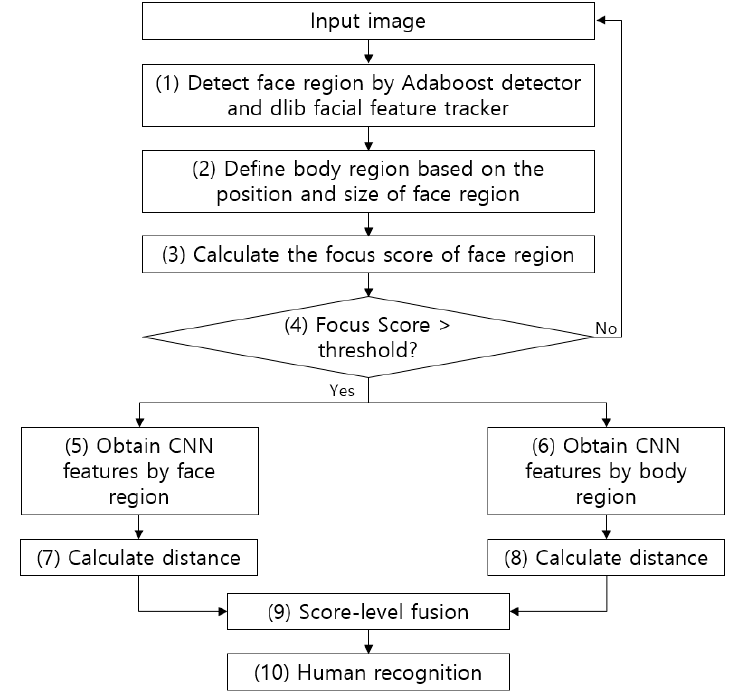
Figure 1. Overall procedure of proposed method.